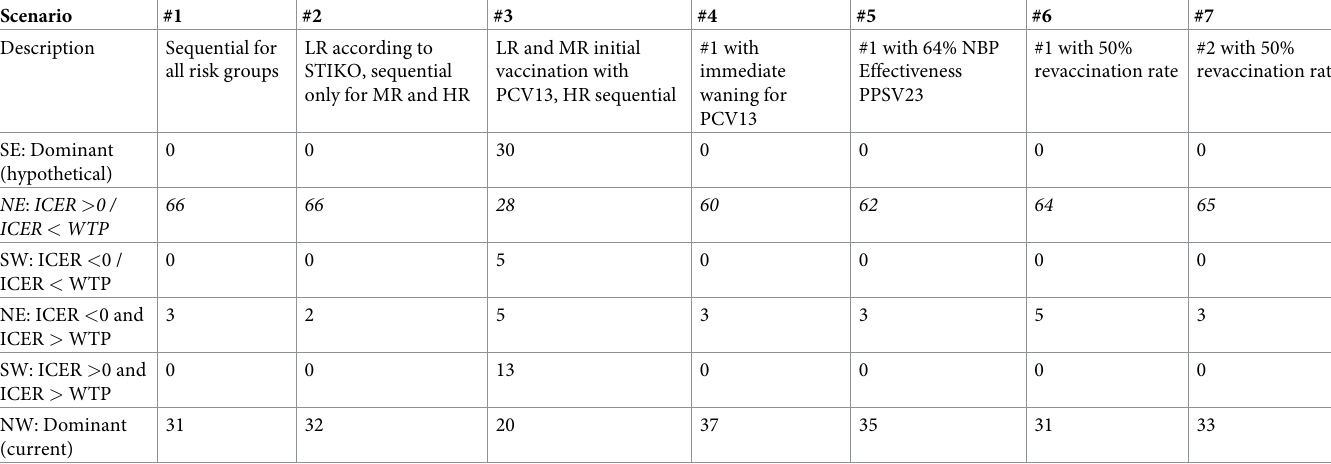
Table 8. Proportion of simulations (%) in the quadrants of the ICER scatterplot.